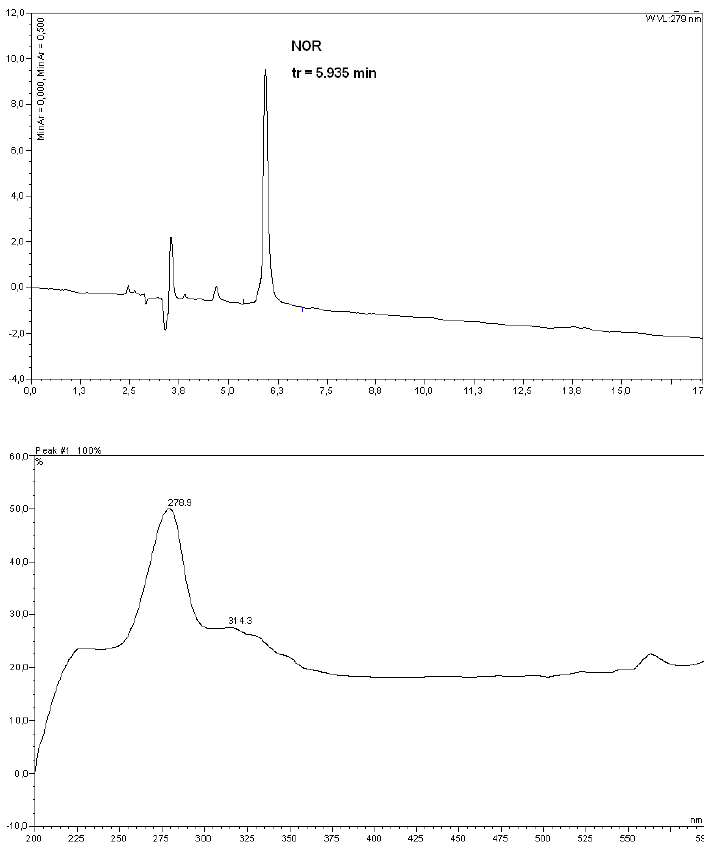
Figure 4. The HPLC chromatogram and UV spectrum of norfloxacin released from polyurethane conjugates (Table 3, Run no. 3, degradation in phosphate buffer, after 21